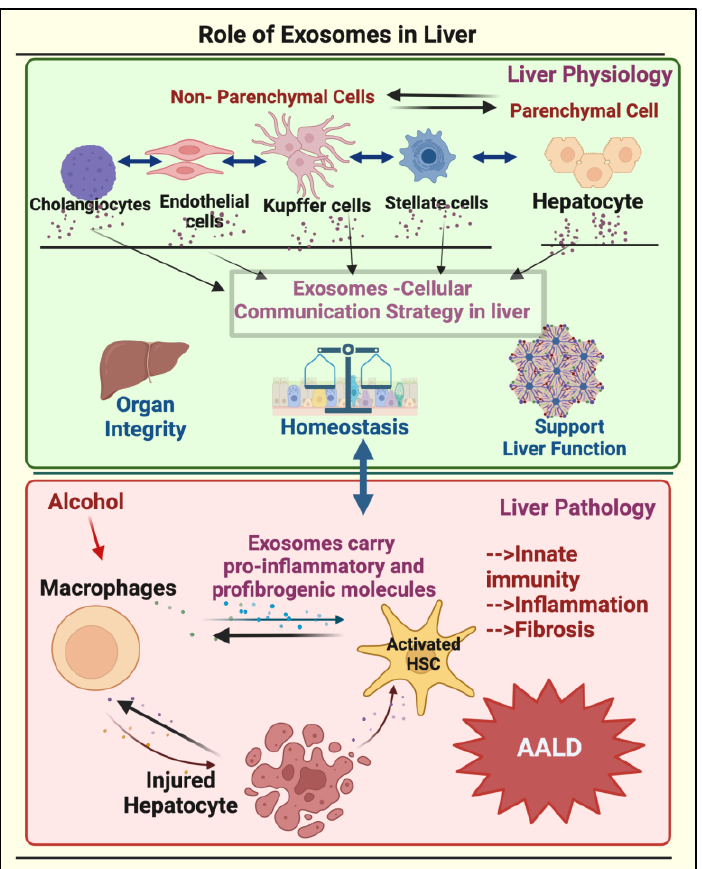
Figure 1. Role of exosomes in the liver. The liver uses exosomes as a cross-communication strategy between parenchymal (hepatocytes) and nonparenchymal cells (cholangiocytes, sinusoidal endothelial cells, Kupffer cells, and hepatic stellate cells (HSC)) for normal functioning and homeostasis. Exosomes derived from hepatocytes, macrophages, or HSCs upon ethanol exposure alter the functions of each other, leading to the progression of ALD.